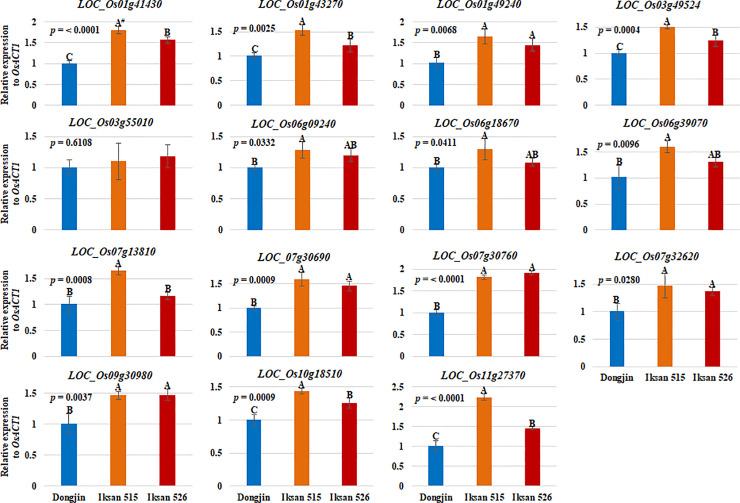
Verification of the expression level of selected UGTs (fold change ≥ 2), differentially expressed between Dongjin and I.526 seeds at 20 DAH, in 9 DAH seeds of Dongjin, I.515 and I.526, respectively, by RT-qPCR.Data represent mean ± standard deviation (SD). The p-values were obtained from the analysis of variance (ANOVA). #: Duncan’s Multiple Range Test (DMRT), α = 0.05.